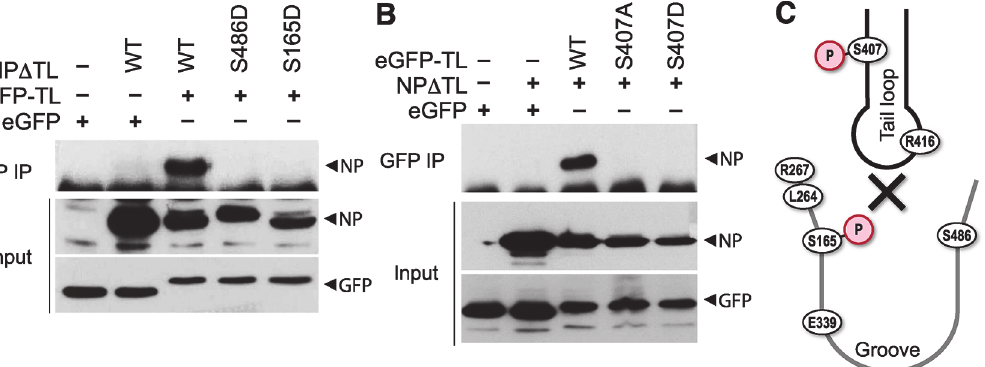
Fig 7. Phosphorylation of the tail loop and binding groove maintains monomeric NP. Binary tail loop-binding groove interactions were directly probed using an NP tail loop deletion mutant (NP Δ TL) and a tail loop fused to eGFP (eGFP-TL). (A) Binding groove mutants were investigated by co-expressing WT or mutant NP Δ TL with eGFP-TL in 293T cells. Lysates were immunoprecipitated with anti-GFP antibody and co-precipitating NP was visualized by blotting with anti-RNP antibody. Expression levels of interacting partners were analyzed by blotting total proteins with anti-RNP or anti-GFP antibodies. (B) The impact of tail loop mutants was probed by co-expressing WT or mutant eGFP-TL with NP Δ TL. Complexes were immunoprecipitated and detected as above. (C) Schematic depiction of how phosphorylation might block entry of the tail loop into the binding groove and inhibiting NP